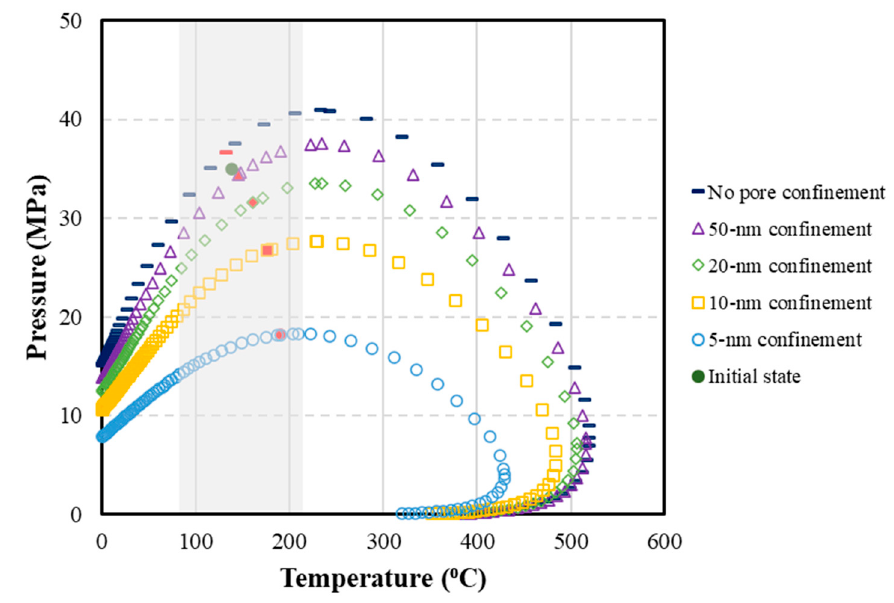
Figure 9. Phase envelopes of the volatile oil with different pore sizes.